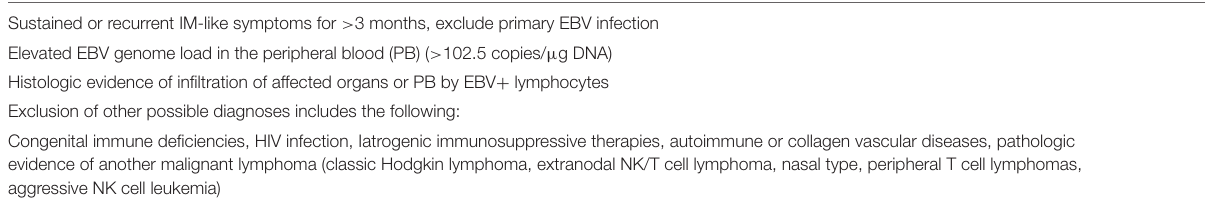
TABLE 1 | Diagnostic criteria of chronic active EBV infection of T and NK cell type (9). Sustained or recurrent IM-like symptoms for > 3 months, exclude primary EBV infection Elevated EBV genome load in the peripheral blood (PB) ( > 102.5 copies/ µ g DNA) Histologic evidence of infiltration of affected organs or PB by EBV + lymphocytes Exclusion of other possible diagnoses includes the